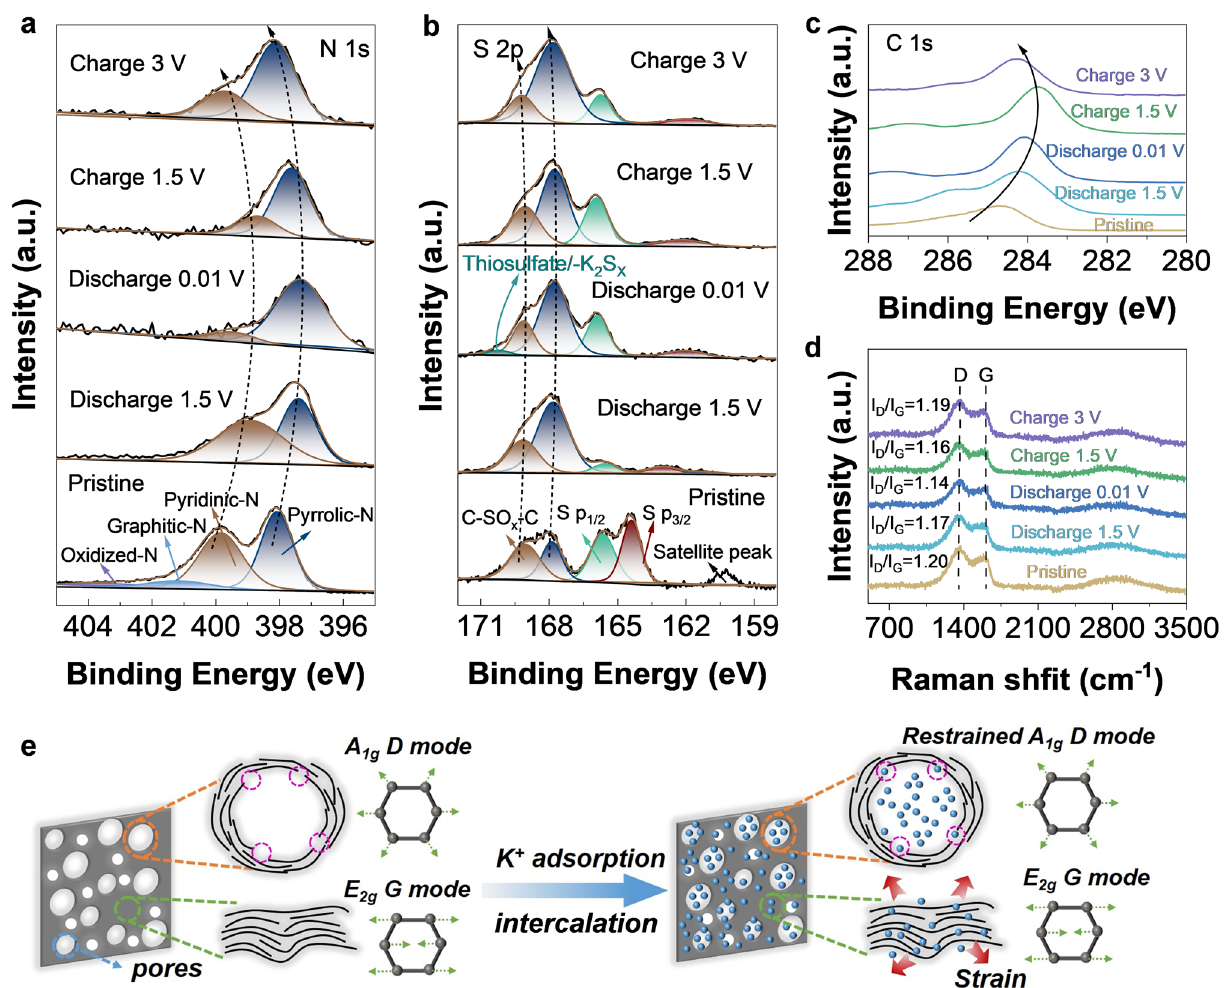
Fig. 7 Potassium-ion storage mechanism study of the NSLPC-700. Ex situ XPS a N 1 s , b S 2 p and c C 1 s spectra of NSLPC-700 anode d Ex situ Raman spectra of NSLPC-700 anode. e Schematic illustrating the potassium-ion storage in amorphous defect-rich